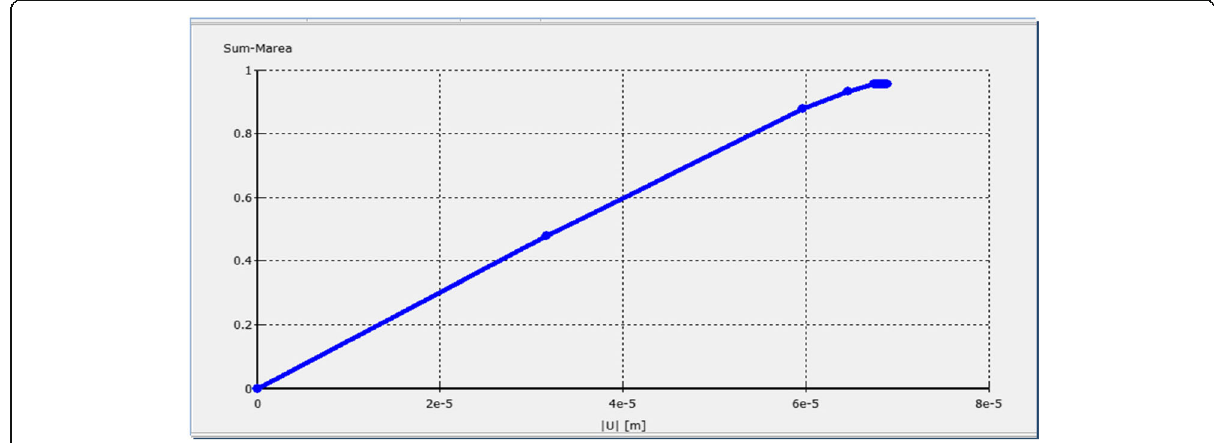
Fig. 27 Displacement progressive curve for the supported rock pillars in KV5